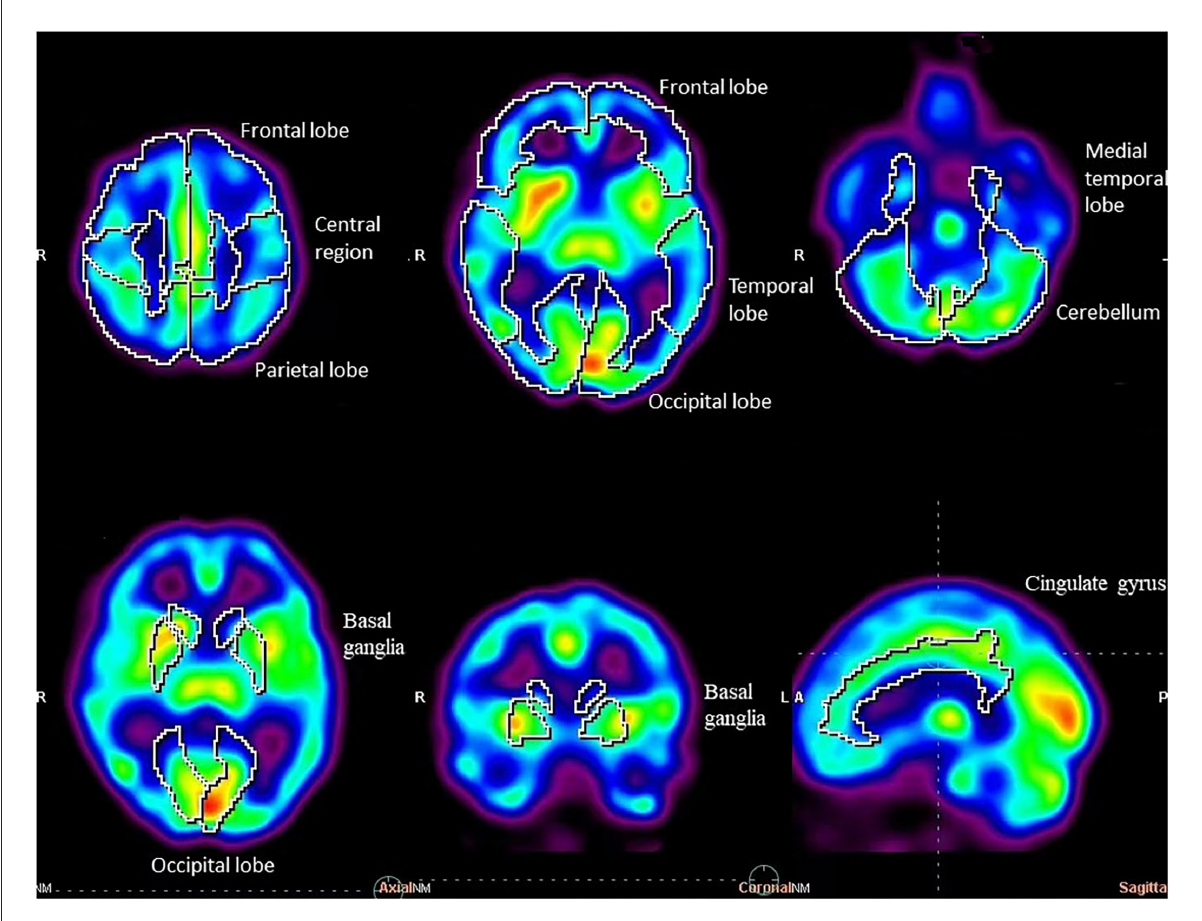
FIGURE2 SPECT standard regions of case 15, a 23-year-old